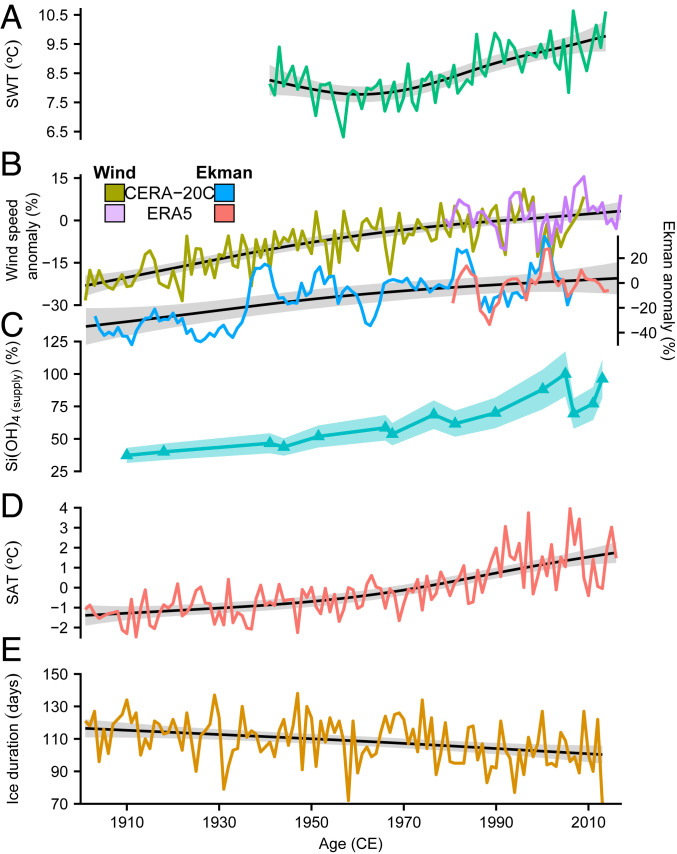
Drivers of silicic acid supply in Lake Baikal. (A) Mean surface water temperatures (SWTs) (May to October) from shoreline locations across Lake Baikal (29). (B) CERA-20C (32) and ERA5 (33) wind speed reanalysis data from the barycentre of Lake Baikal and modeled 5-y running mean Ekman transport in Lake Baikal during the typical periods of downwelling (May to June and December to January). Both datasets are shown as anomalies relative to a baseline period of 1990 to 2000 CE. (C) Changes in photic zone silicic acid supply relative to a value of 100% at 2005 CE with the shaded polygon reflect the 1σ uncertainty derived from Monte Carlo simulations (10,000 replicates). (D) Annual mean surface air temperature (SAT) at Irkutsk (World Meteorological Organization station 30710 [52°16′20″ N, 104°18′29″ E; elevation, 467 m]) (Fig. 1). (E) South basin annual ice cover duration. The black lines and gray confidence intervals on individual panels show a GAM fitted to each time series.